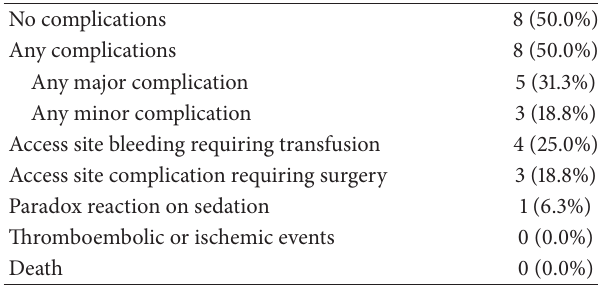
Table 3: Procedural